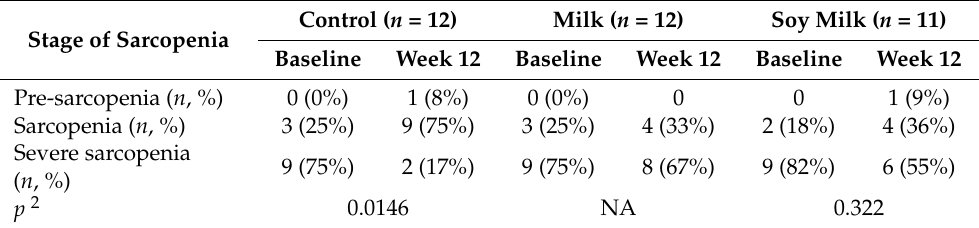
Table 4. Effects of milk or soy milk combined with resistance exercise on the stage of sarcopenia in very old nursing home residents with sarcopenia 1